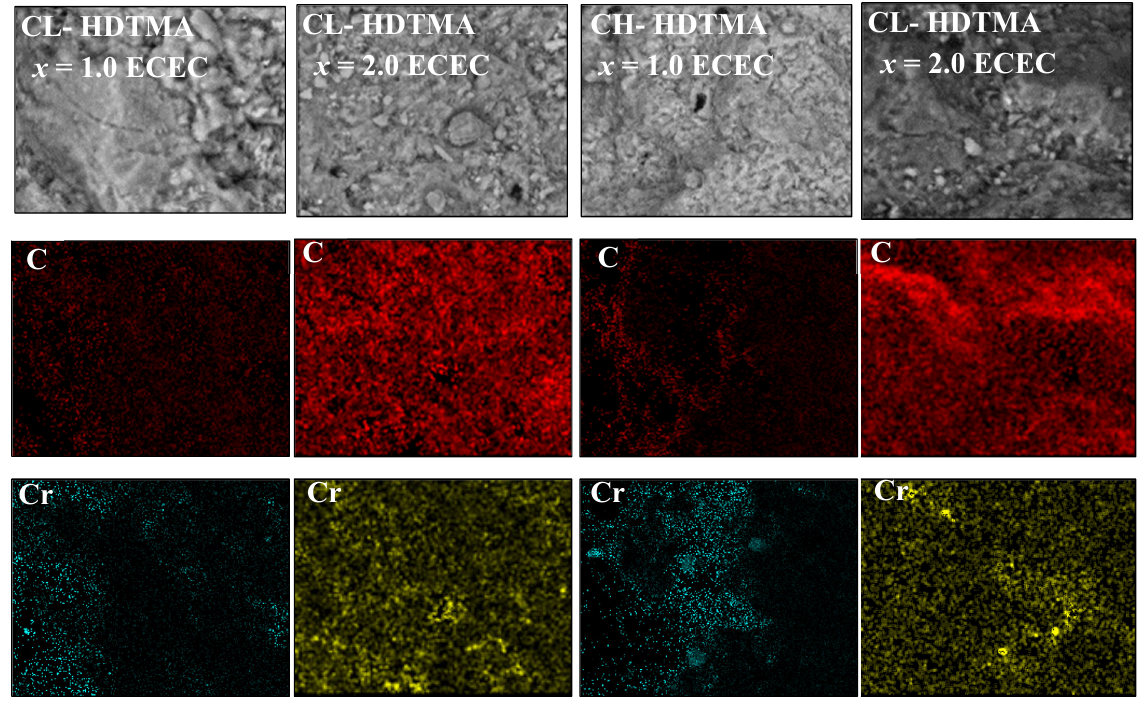
Figure 8. SEM-EDX C and Cr element mapping images of SMZ before and after Cr(VI) sorption.